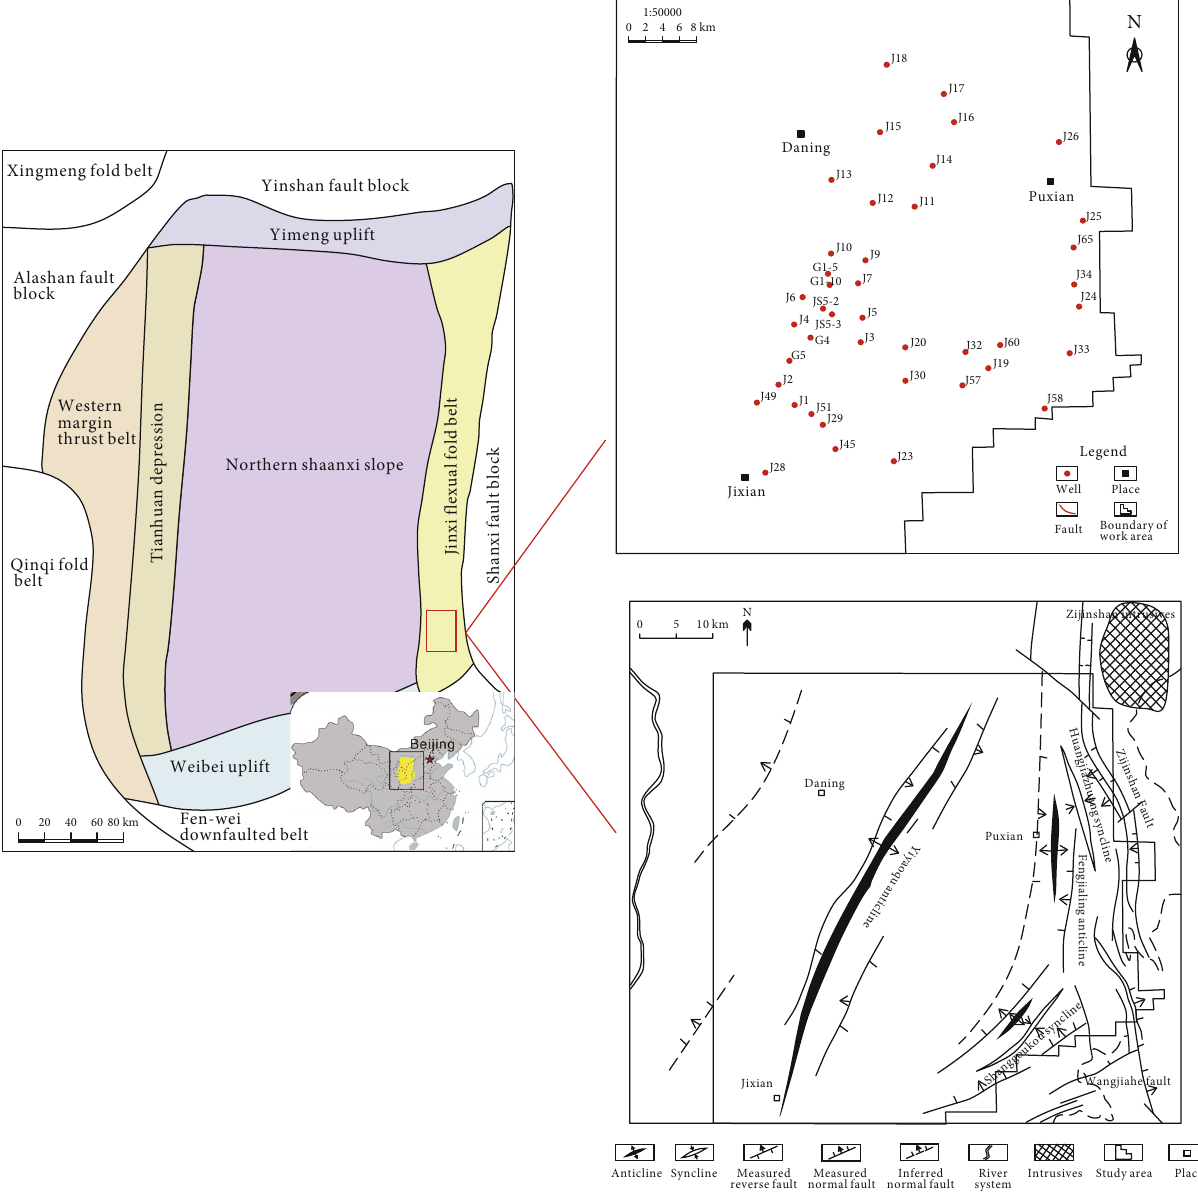
Figure 1: The location of the study